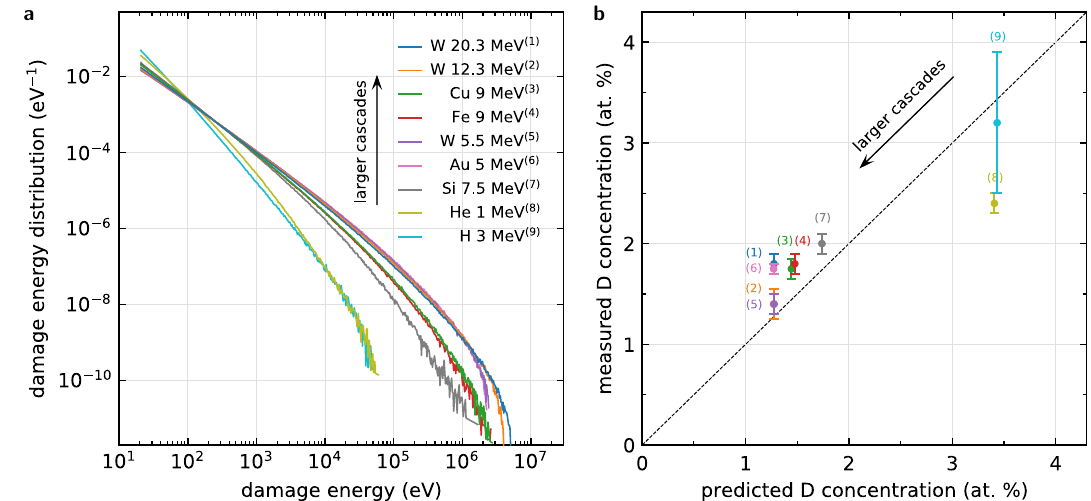
Figure 5. Saturated deuterium content in the high dose limit. ( a ) Distribution of cascade damage energies for various irradiation ions. Ions with higher momentum are more likely to generate higher energy cascades. ( b ) Comparison of analytically predicted (9) and experimentally measured deuterium concentrations in the saturated limit. Irradiation with lower momentum ions leads to a higher deuterium content, consistent with the higher vacancy content produced by smaller cascades. Colors and labels are consistent with damage energy spectra from Fig. 5a. Measured concentrations extracted from (6) 33 , (1, 3, 4, 7, 8) 37 , (5) 38 , (2) 39 , (9) 40